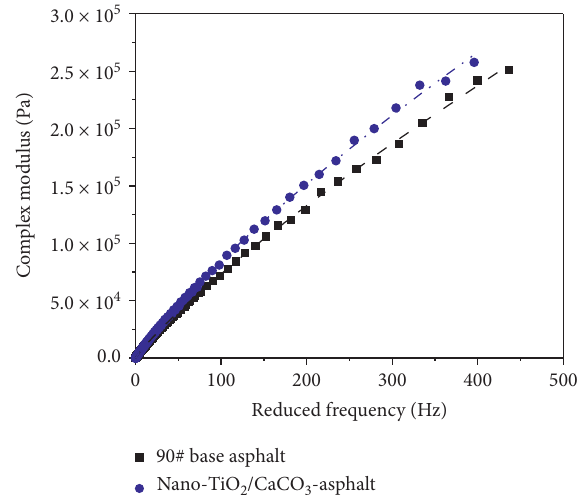
Figure 7: Master curve of complex modulus for base bitumen and nano-TiO 2 /CaCO 3 -modified